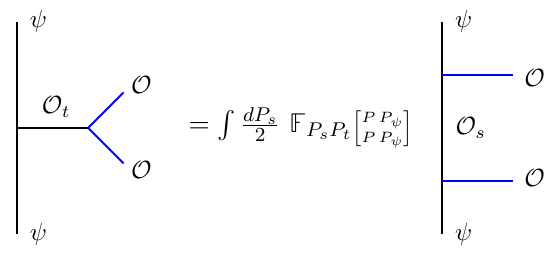
Figure 1 . Diagram of the fusion transformation that was used to compute the left moving vacuum block in the appropriate limit. The blue lines correspond to the two operator